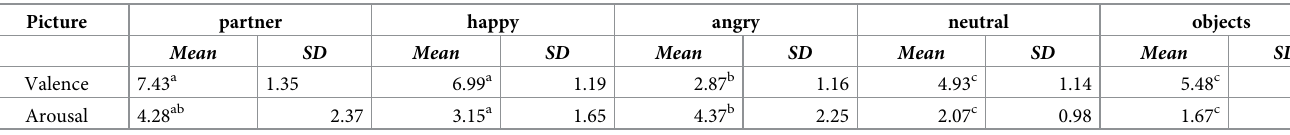
Table 2. Valence and arousal ratings ( M , SD ) for the